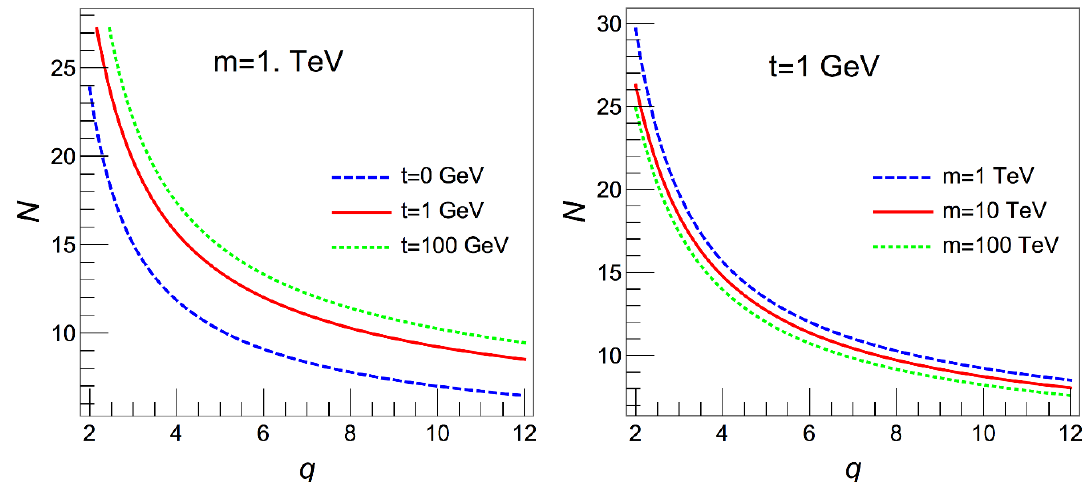
Figure 1 . Contours indicating the values of q and N that satisfy the observed relic abundance for (cid:20) = 1. Left : we choose m = 1 TeV and show contours for three di(cid:11)erent choices of the mass parameter t = f 0 ; 1 ; 100 g GeV. Right : we choose t = 1 GeV and show contours for three di(cid:11)erent choices of the mass parameter m = f 1 ; 10 ; 100 g